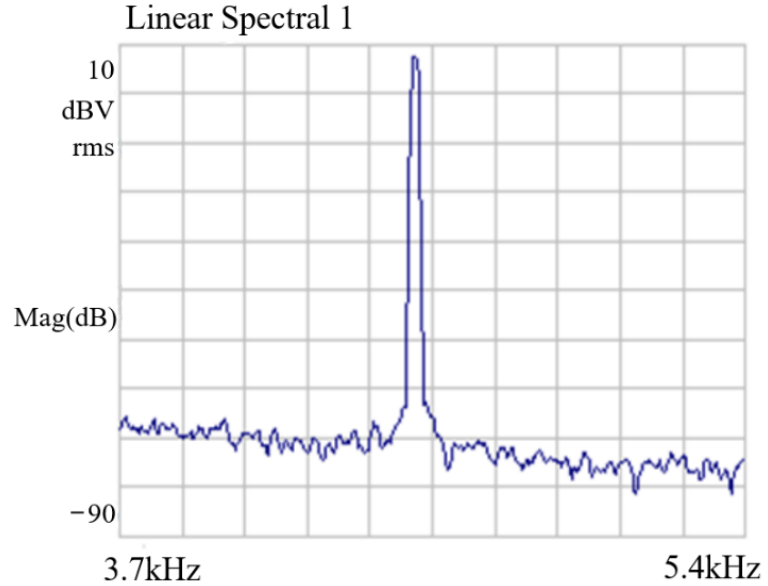
Figure 13. Spectrum of drive signal.